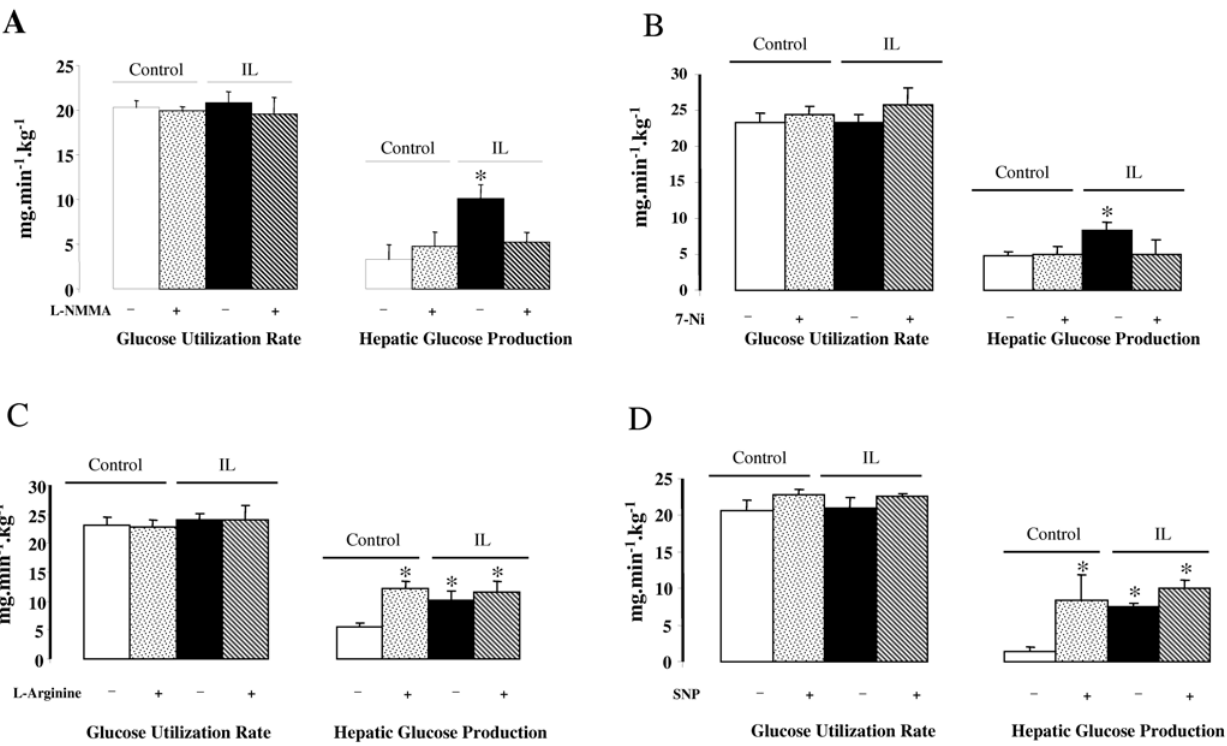
Figure 5. Glucose turnover rate during euglycemic-hyperinsulinemic clamps. Glucose Utilization and Hepatic Glucose Production during euglycemic-hyperinsulinemic clamp (0.4 U ? kg 2 1 ? h 2 1 ) in Control and IL rats before and after L-NMMA (A), 7-Ni (B). L-Arginine (C) or SNP (E) carotid injection. L-NMMA: non selective NOS inhibitor. 7-Ni: selective neuronal NOS inhibitor. W1400: selective inflammatory NOS inhibitor. SNP: chemical NO donor. Values are means 6 SEM in each group. * p , 0.01 vs C rats.